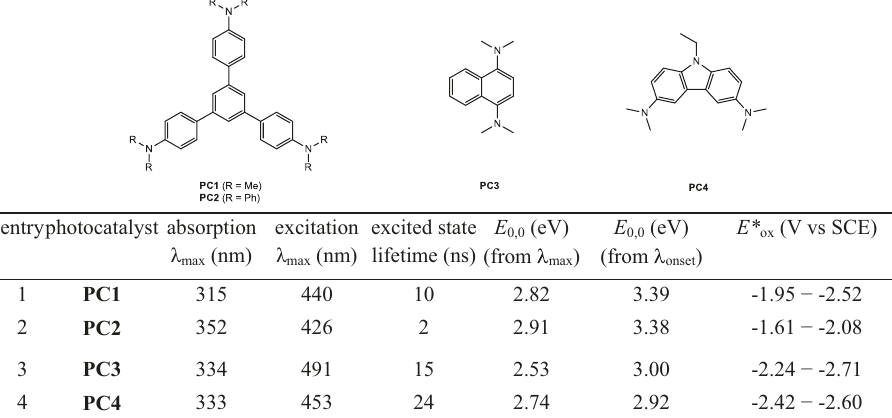
Fig. 2 Photophysical and electrochemical properties of arylamine-based photocatalysts PC1 − PC4. All the data are measured in DMSO (0.10 or 1.0 mM) solution at room temperature. PC, photocatalyst; DMSO, dimethyl sulfoxide.